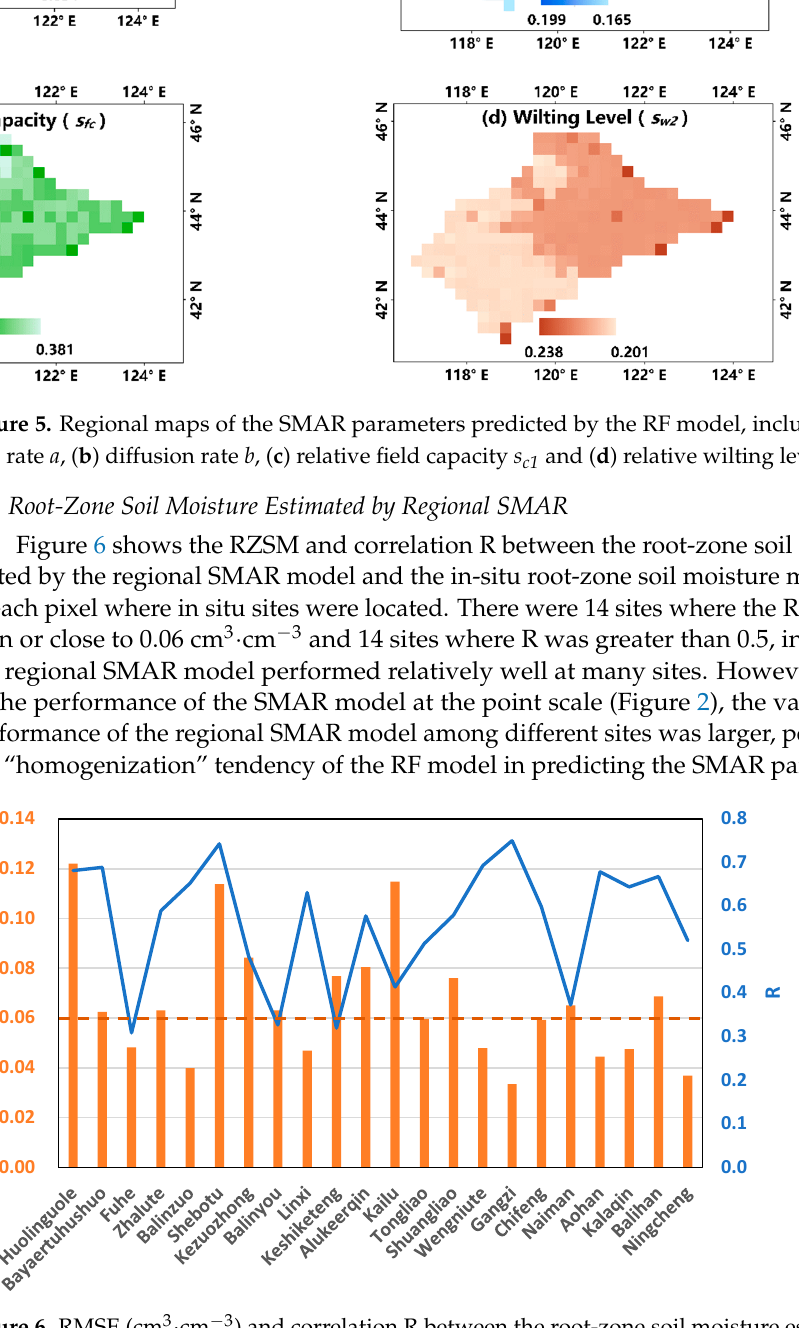
Figure 6. RMSE (cm 3 · cm − 3 ) and correlation R between the root-zone soil moisture estimates by the regional SMAR and the in-situ root-zone soil moisture measurements at each pixel where in situ sites were located. The dashed line represents NASA’s quality benchmark (0.06 cm 3 ·cm − 3 ) for soil moisture predictions using satellite observations.